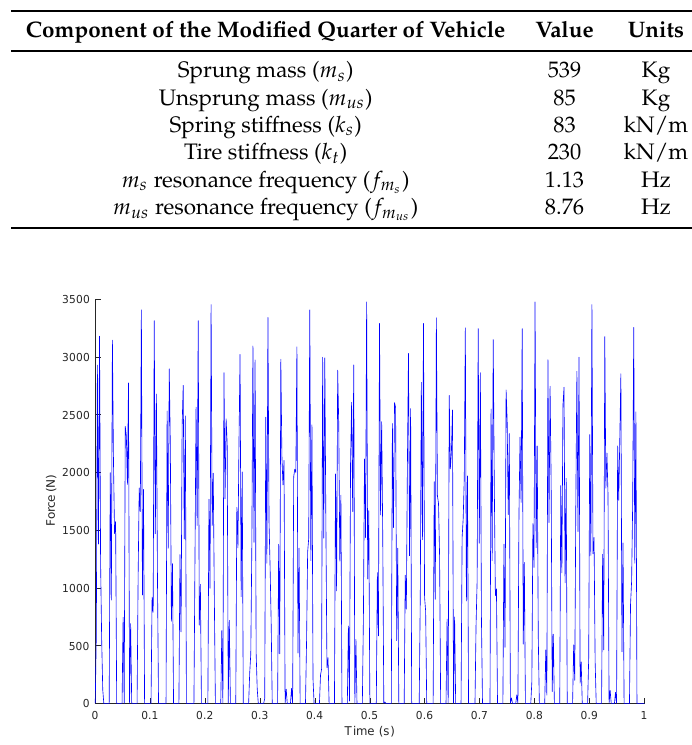
Table 5. Modified front QoV parameters.